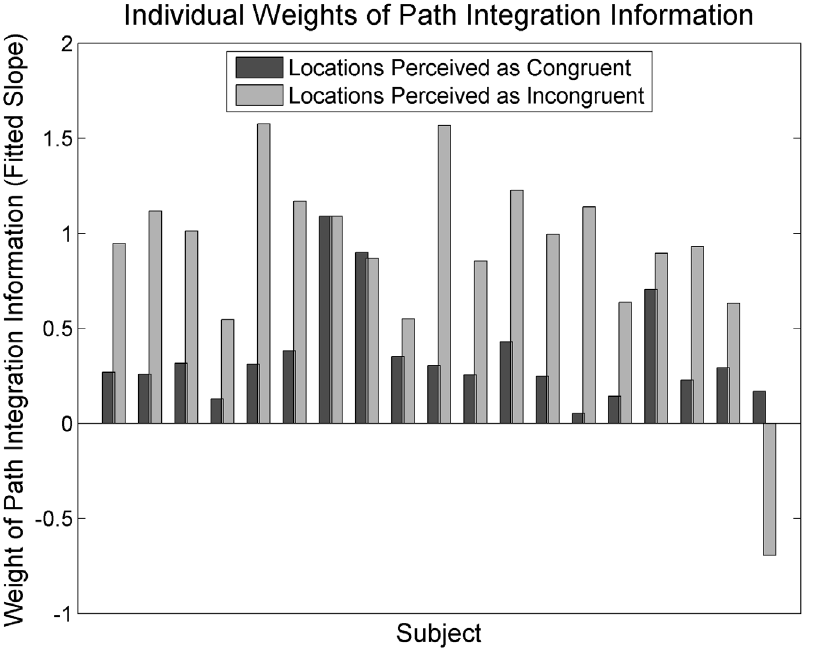
Figure 3. Participants’ weighting of path integration in the combined cue task. Amount of weight (and 95% confidence interval) that participants gave to path integration in the combined cue task. Weights were computed from participants’ estimates of their location in the hallway.